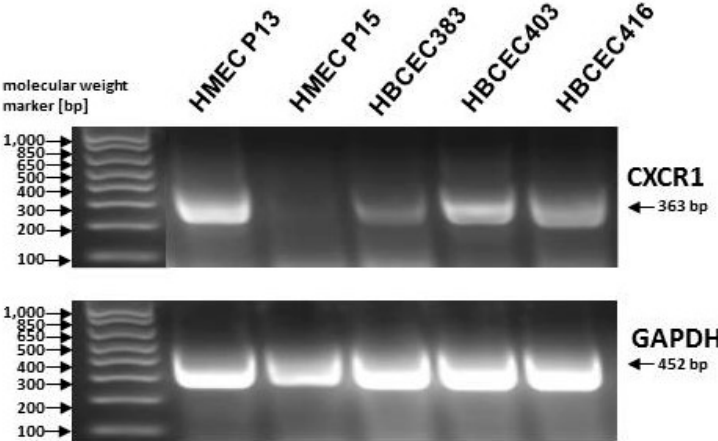
Figure 2. Detection of the IL-8 receptor, CXCR1, by RT-PCR in young proliferating human mammary epithelial cells (HMEC) in passage 13 and in three different patient-derived human breast cancer epithelial cell (HBCEC) populations in contrast to growth-arrested senescent HMEC in passage 15 [104]. The expression of CXCR1 is a phenotypic feature of BCSCs since these cells were reported to depend on IL8 signaling for survival [102]. Amplification of glyceraldehyde-3-phosphate-dehydrogenase (GAPDH) transcripts (amplification product: 452 bp, [28]) served as a control. The PCR primers used were: CXCR1 sense: 5 (cid:48) -GGG GCC ACA CCA ACC TTC-3 (cid:48) , antisense: 5 (cid:48) -AGT GCC TGC CTC AAT GTC TCC-3 ′ , amplification product: 363 base pairs Scientific, Carlsbad, CA, USA).